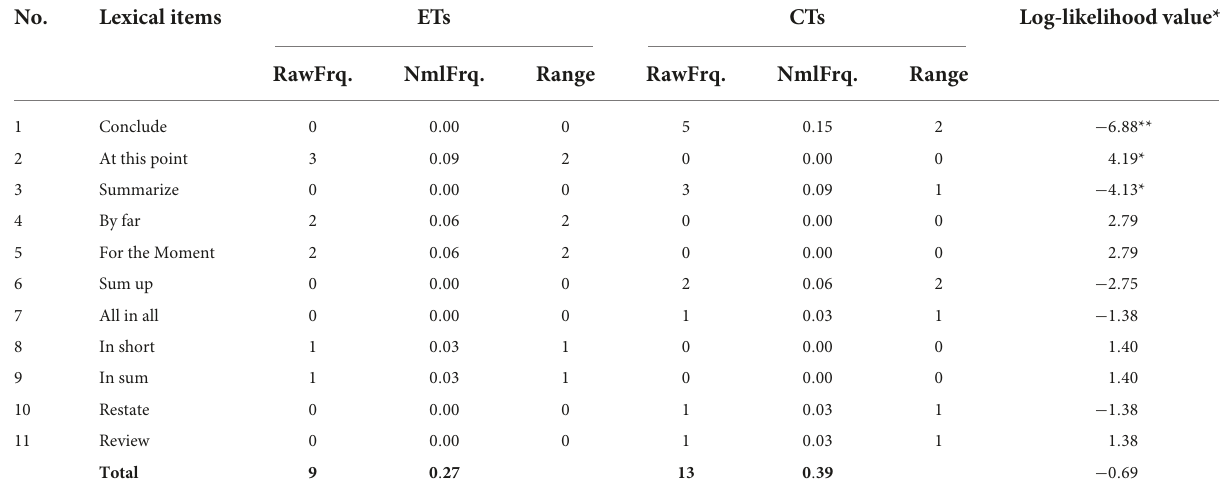
TABLE 7 Summary of labeling stages in both